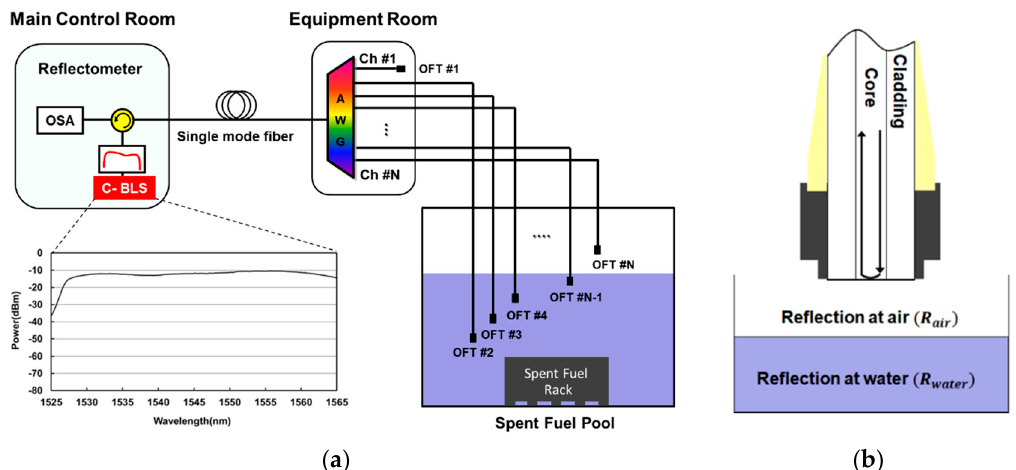
Figure 1. ( a ) Configuration of the proposed all-optical water level monitoring system, and ( b ) schematic drawing of optical fiber tip.